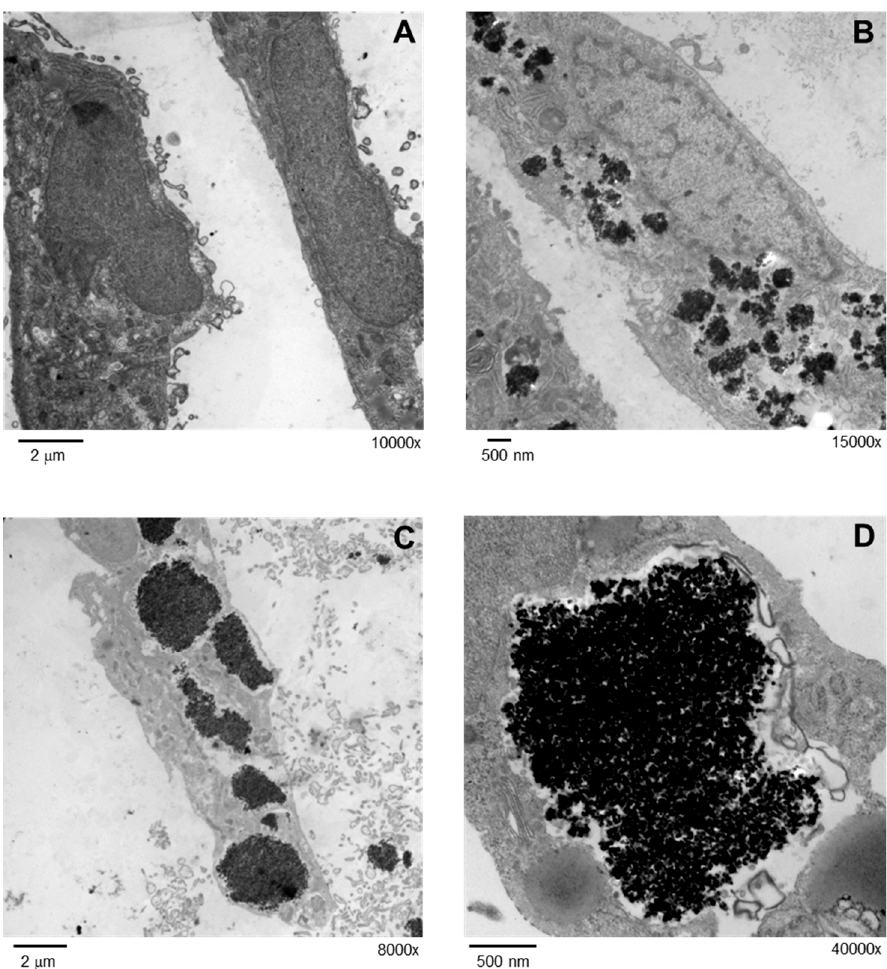
Figure 1. Internalization of TiO 2 NPs was evaluated by TEM. Cells were treated with 5 μ g/cm 2 TiO 2 NPs for 24 h and analyzed in a JEOL 10 ‐ 10 microscope and an AMT Camera System. TEM micrographs of non ‐ exposed cells at a direct magnification of 10,000× ( A ) and treated cells a magnification of 15,000× ( B ), 8000× ( C ) and 40,000× ( D ) are shown.